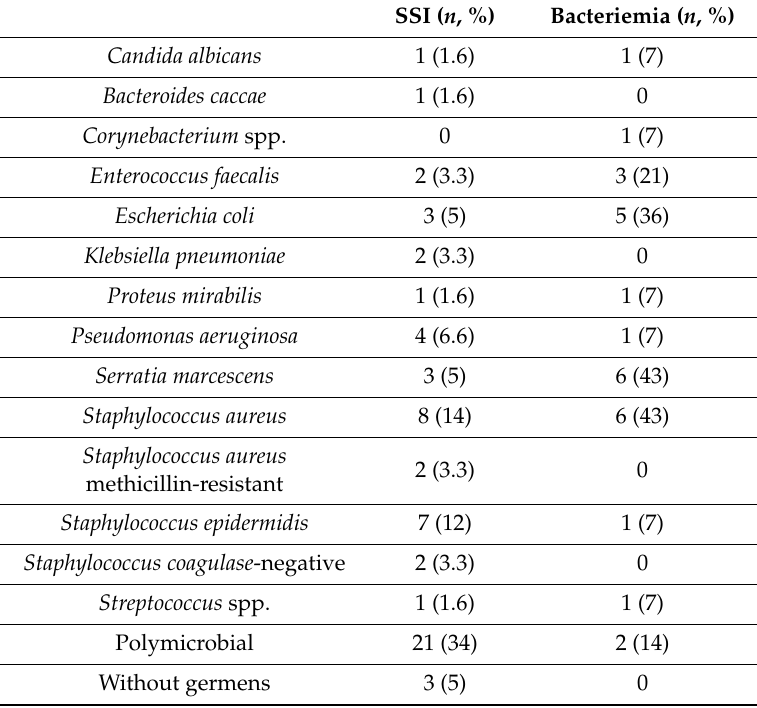
Table 2. Isolated microorganisms from patients with SSI or bacteremia.